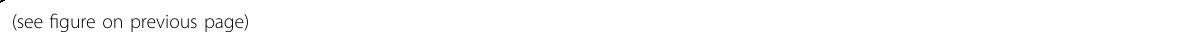
Fig. 6 Gab2 regulates UCP1 expression by mediating PI3K p85-AKT-FoxO1 signaling pathways. A Representative blots of proteins in undifferentiated and differentiated brown adipocytes detected by immunoblotting analysis. β -Tubulin protein was measured as a loading control. Con, undifferentiated brown preadipocytes; Induced, differentiated brown adipocytes. B Representative blots of proteins in CL316,243-stimulated immortalized brown preadipocytes detected by immunoblotting analysis. The speci fi c p-Gab2 band is indicated by the black arrows. The relative grayscale values of protein blots were normalized with the control protein. β -Tubulin protein was measured as a loading control. C , D Representative blots and relative grayscale values of Akt-FoxO1 signals in Gab2 de fi ciency primary brown preadipocytes ( C ) or in Gab2 overexpression immortalized brown preadipocytes ( D ) stimulated with CL316,243 detected by immunoblotting analysis. β -Tubulin protein was measured as a loading control. The speci fi c p-Gab2 band is indicated by the black arrows. E , F The interaction between Gab2 and PI3K p85 in primary brown preadipocytes stimulated with CL316,243(5 μ M) for 30 min ( E ) or in BAT of mice injected with CL316,243 (1 mg/kg/day) for 3 days ( F ) detected by immunoprecipitation. The data are presented as mean ± SD from three independent experiments. Statistical difference is indicated: * P < 0.05; ** P <